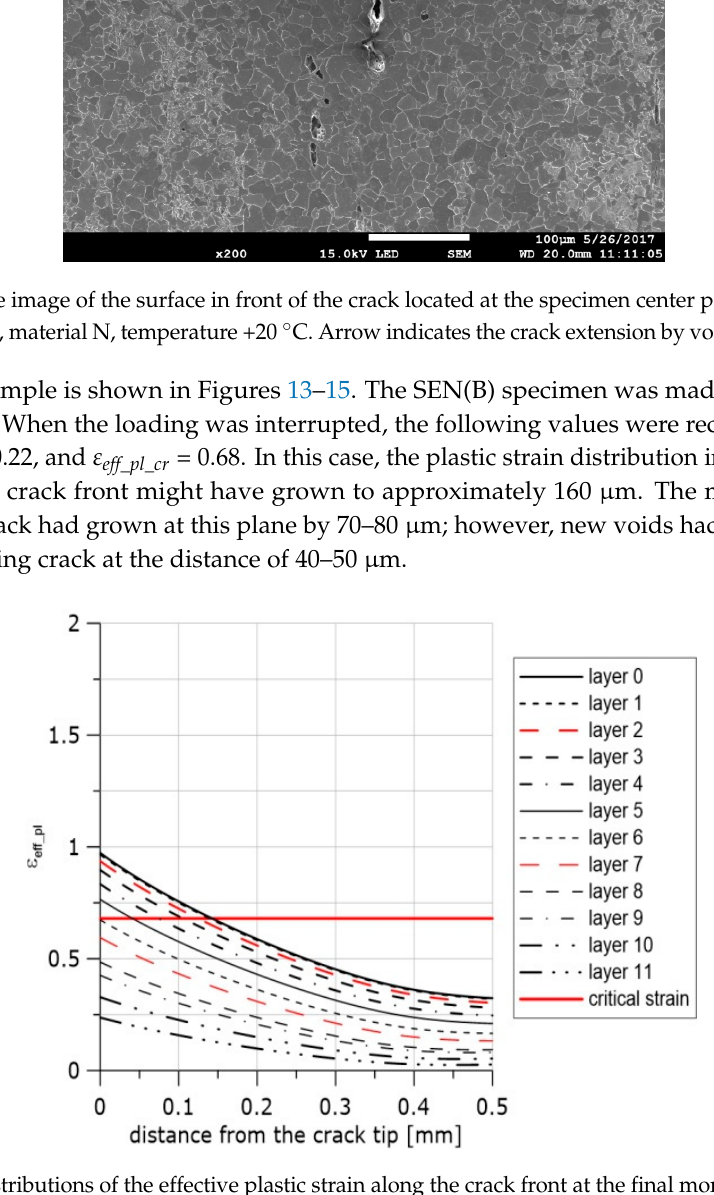
Figure 13. Distributions of the effective plastic strain along the crack front at the final moment of loading after calibration using specimen PR and the material softening option, material NW, temperature − 50 °C.